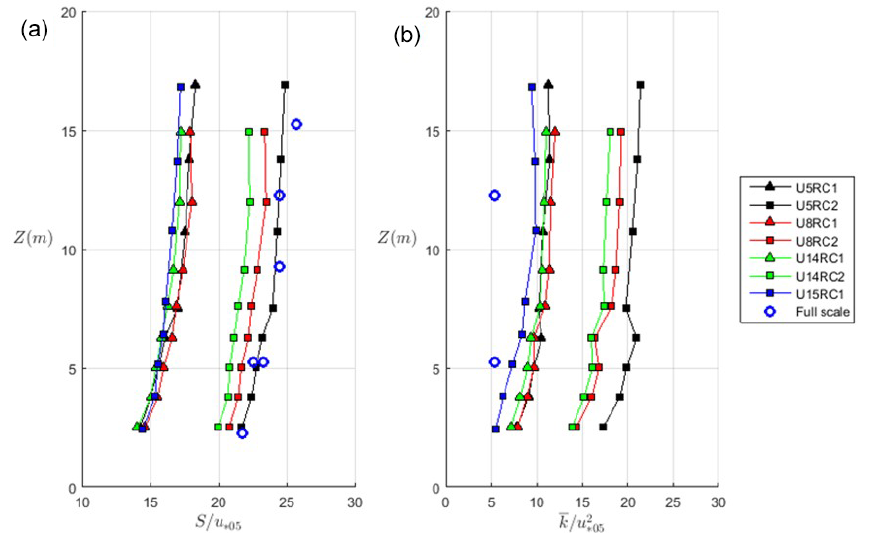
Figure 4. WindEEE inflow profiles of (a) mean flow speed and (b) TKE, normalized by friction velocity obtained using Method 1. S and k calculated using all three components of wind speed from Cobra probe measurements. Z co-ordinates shown in full-scale units.